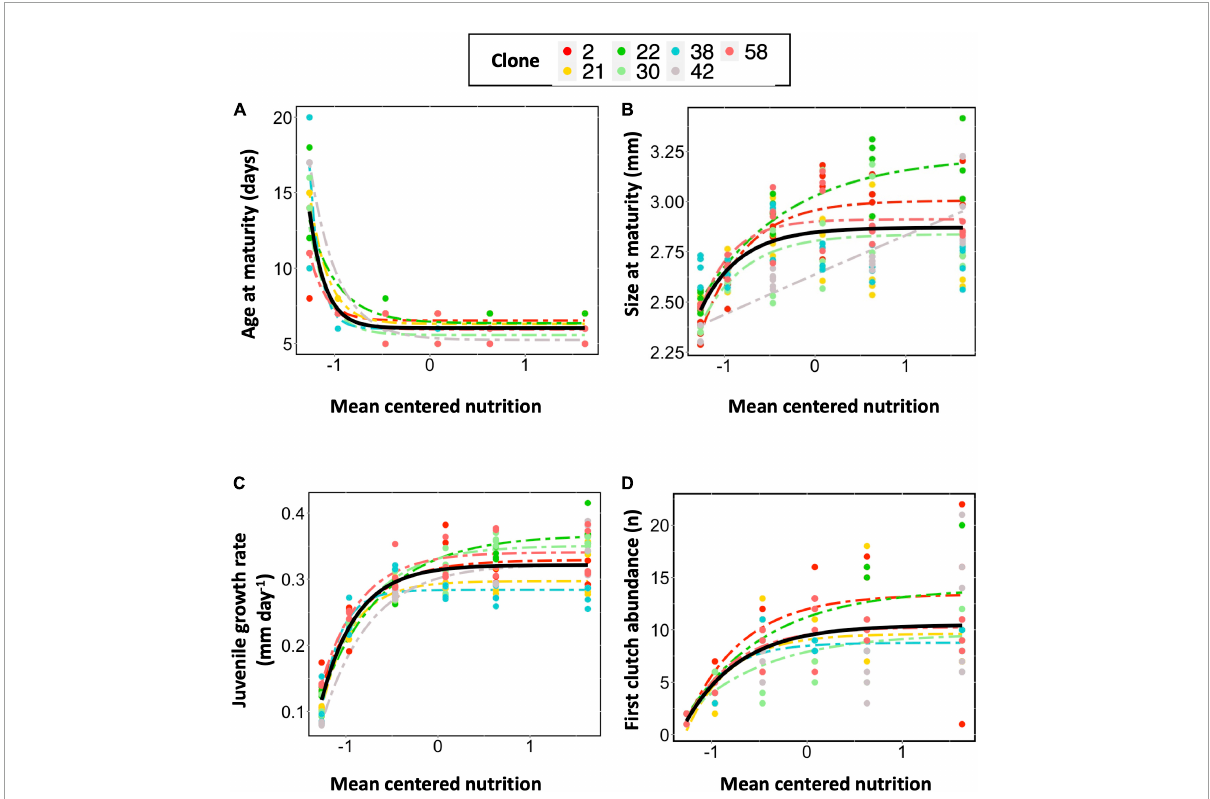
FIGURE2 Population-level and clonal-level reaction norms for (A) Age at maturity, (B) Size at maturity, (C) Juvenile growth rate and (D) First clutch abundance. For each trait we utilized the best fitting model from the RRMM analysis. Mean-centered food was included as a fixed effect. Clonal variation in model parameters were included as a random effect. The solid black line shows the model fit for the population. The colored dots show the raw data for each clone and the colored dashed lines show the model fit for each clone. For age at maturity the best fitting model included a clone-specific slope term whereas for all other traits the best fitting model included clone-specific intercept and asymptotes. Clone 21 and 38 did not conform with the asymptotic model for size at maturity and clone 42 did not conform with the asymptotic model for first clutch abundance so these clones were not included in the plots visualizing clone-specific fits for these